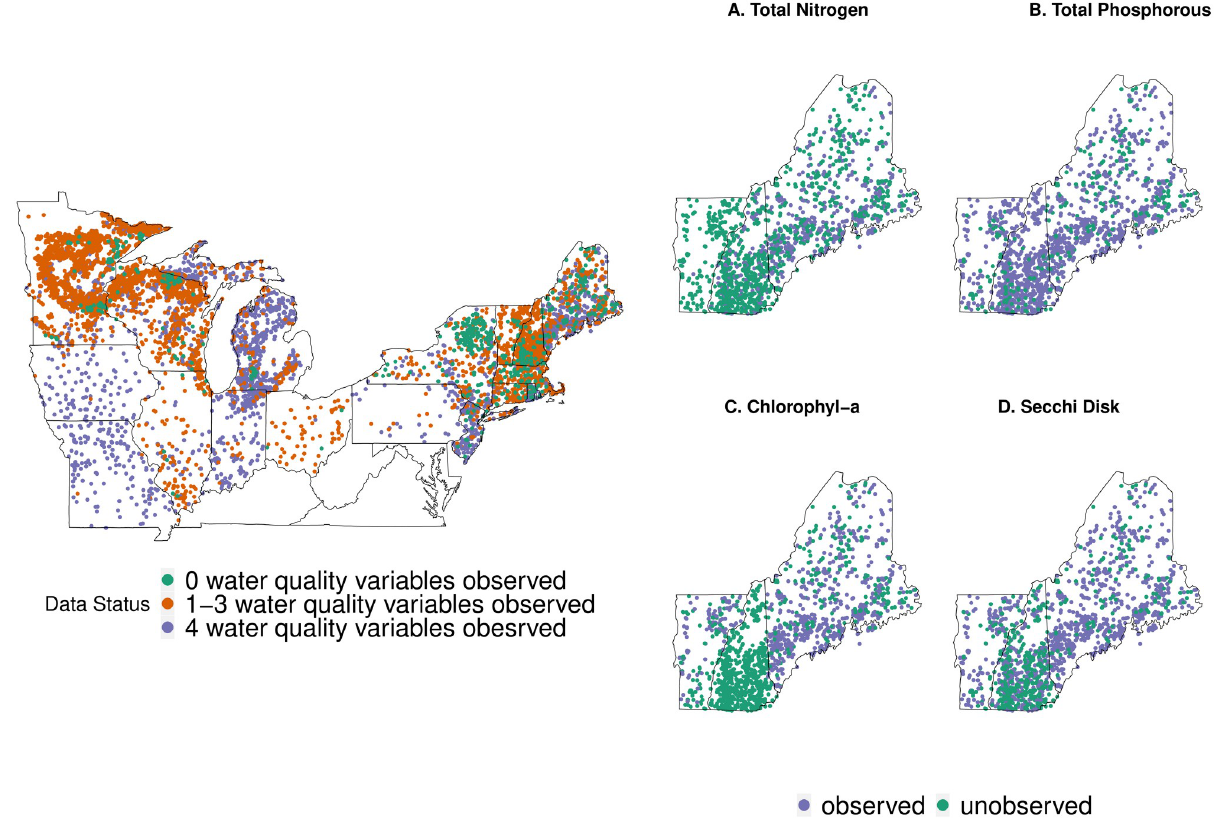
Fig 2. Left: map of inland lake locations with full, partial, or missing response variables. Missing response variables are lakes where all water quality measures have not been observed, while partial status indicates only some lake response variables are unobserved. Covariates were quantified for all locations. Right: subset of data status (observed or missing) for each response variable. All spatial plots in this paper were created using the Maps package [15] in R to provide outline of US states.